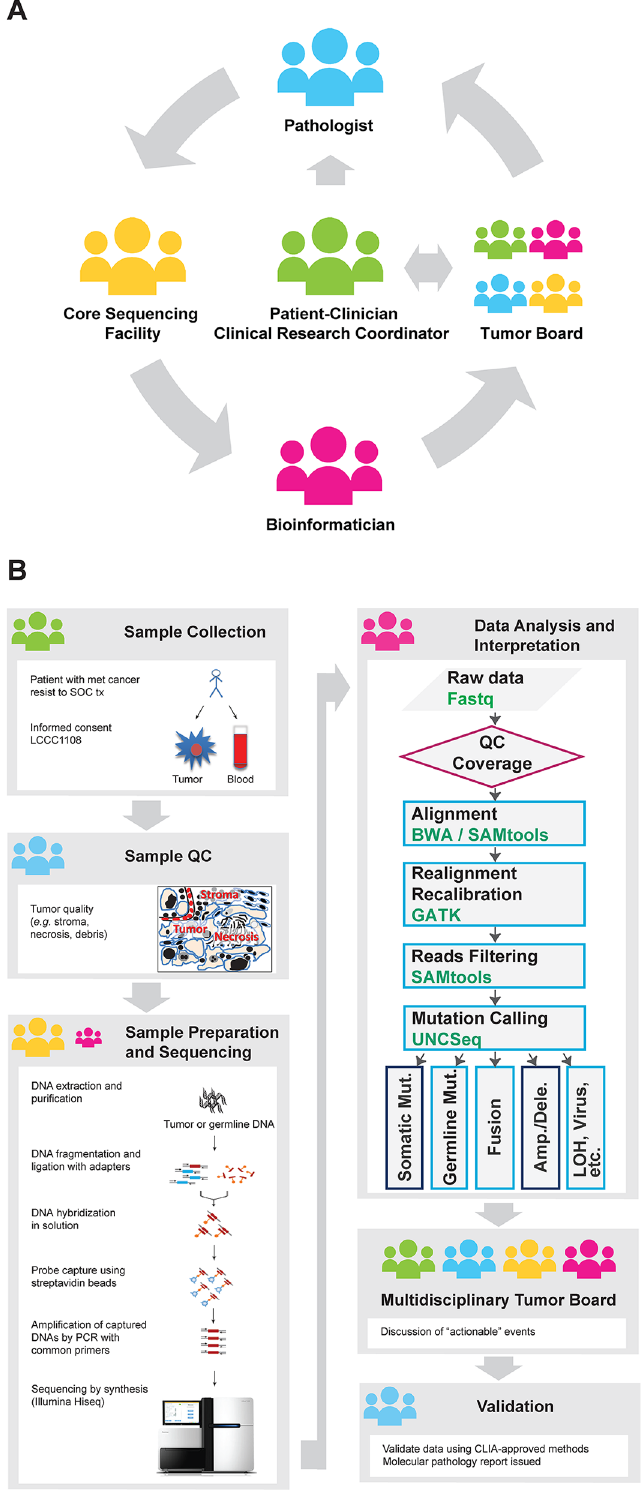
Fig 1. The UNCseq project. (A) The UNCseq project is an initiative that involves clinicians and patients interested to participate in a non-therapeutic clinical trial conducted through the Lineberger Comprehensive Cancer Center (IRB-approved protocol 11 – 1115), as well as a multidisciplinary team that involves clinical